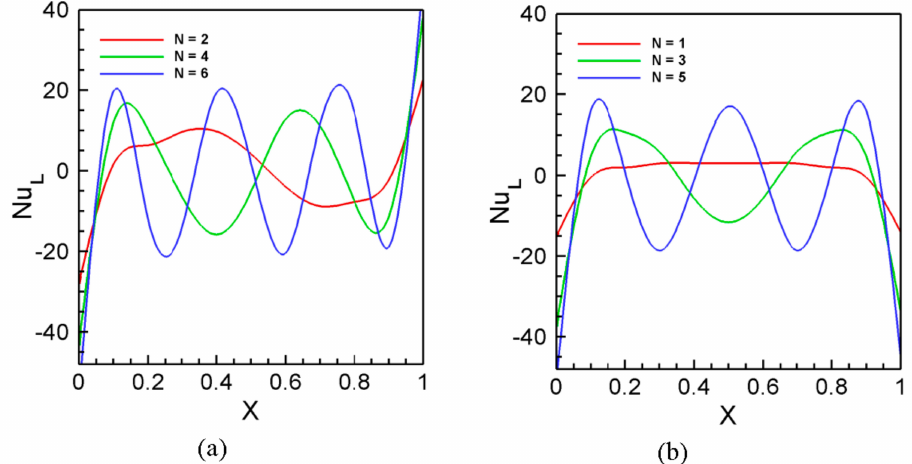
Figure 15. Variation of the local Nusselt number for ( a ) even values of N and ( b ) odd values of N, when Gr = 10 7 and τ = 1.